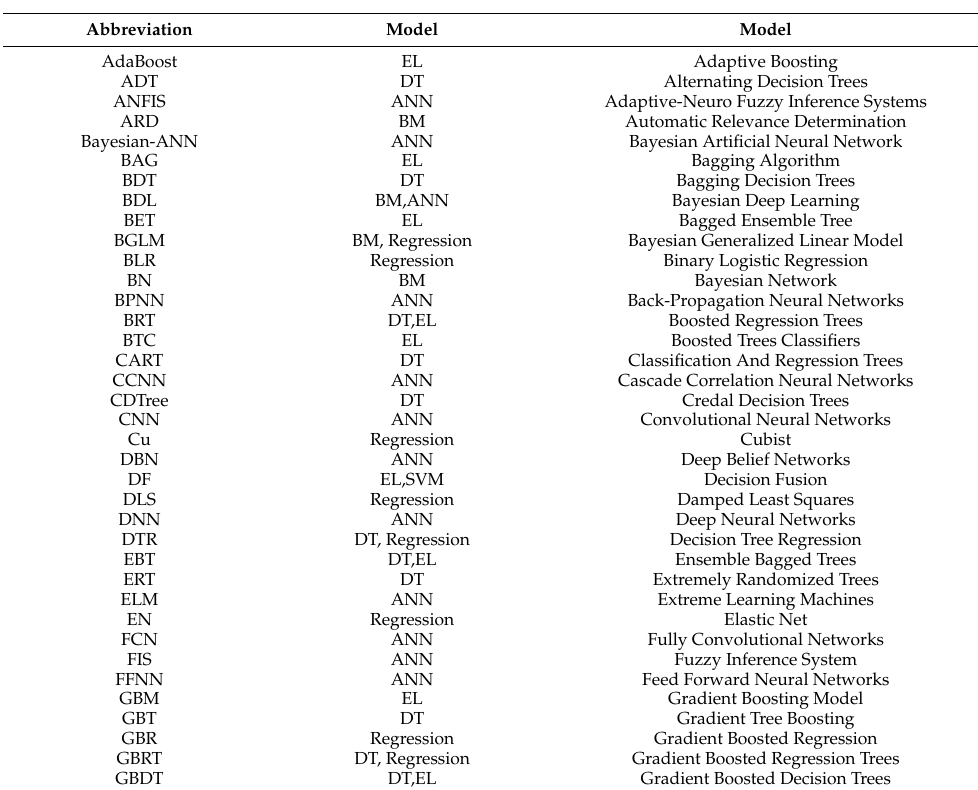
Table A11. Abbreviations for machine learning